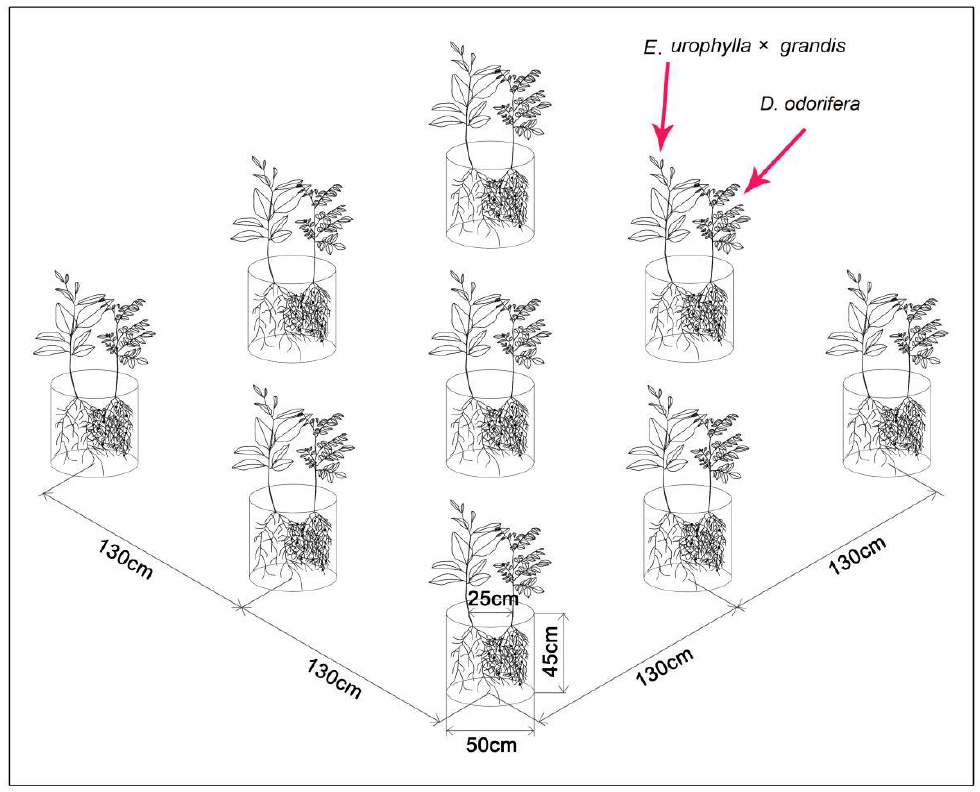
Figure 1. Diagram of E. urophylla × grandis and D. odorifera. Note: In each pot, the plant on the left is E. urophylla × grandis , and the plant on the right is D. odorifera .